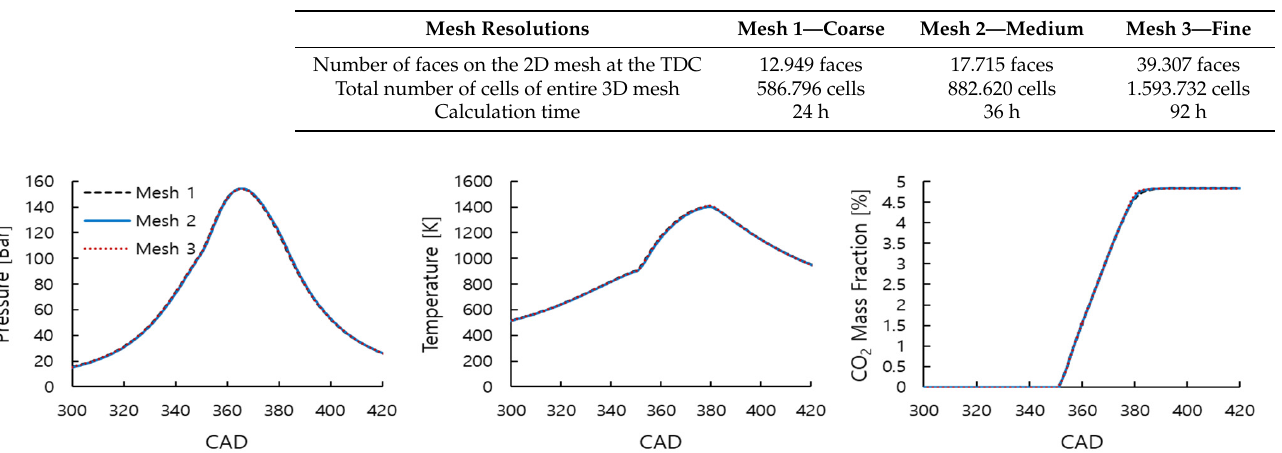
Table 5. Mesh properties and calculation time.